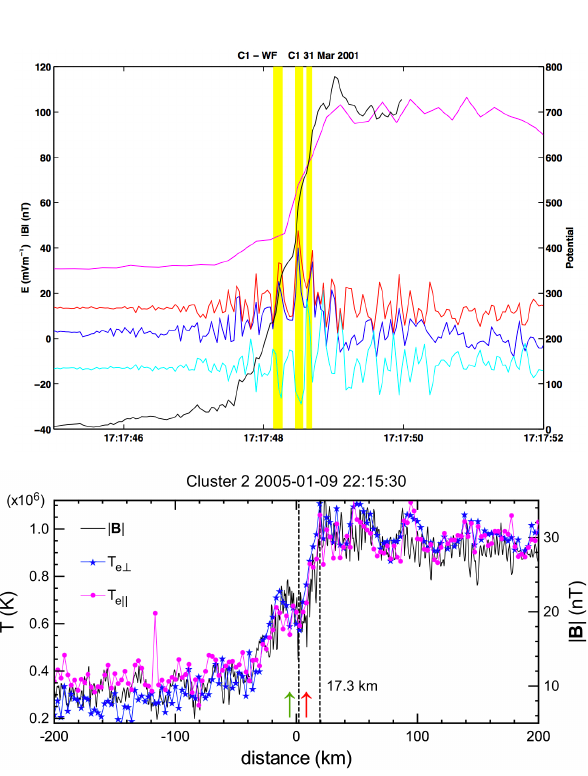
Fig. 5. Small scale structures within the bow shock in the elec- Figure 5. Small scale structures within the bow shock in the electric field (top) and electron 4 tric field (top) and electron temperature (bottom). Top: Spacecraft temperature (bottom). (top) Spacecraft spin plane electric field (red), its two components Ex 5 spin plane electric field (red), its two components E x (blue) and E y (blue) and Ey (cyan), the integrated potential (black) and the total magnetic field (magenta) 6 (cyan), the integrated potential (black) and the total magnetic field from Walker et al, (2004). (bottom) Total magnetic field and electron perpendicular (blue) 7 (magenta) from Walker et al. (2004). Bottom: Total magnetic field and parallel temperature (magenta) from Schwartz et al., 2011. 8 and electron perpendicular (blue) and parallel temperature (ma- genta) from Schwartz et al.